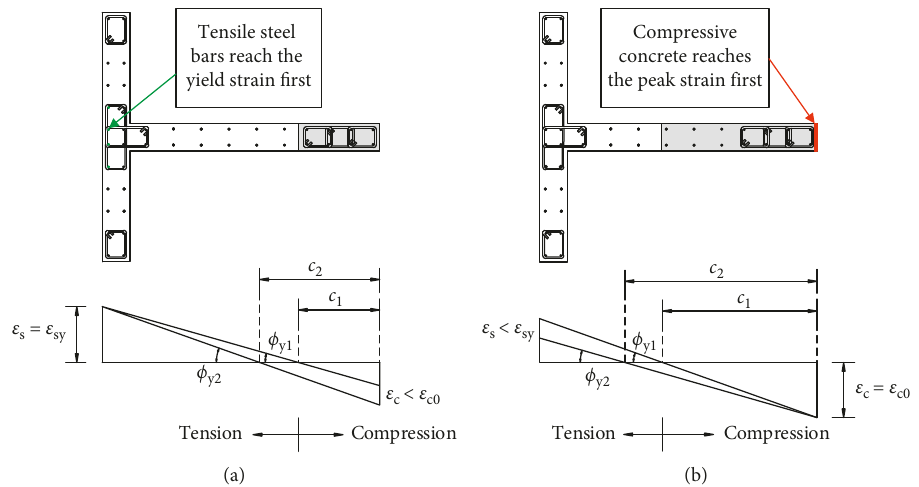
Figure 5: Relationships among the yield curvature, neutral axis depth, and strain. (a) Yielding determined by the tensile steel bars. (b) Yielding determined by the compressive concrete.